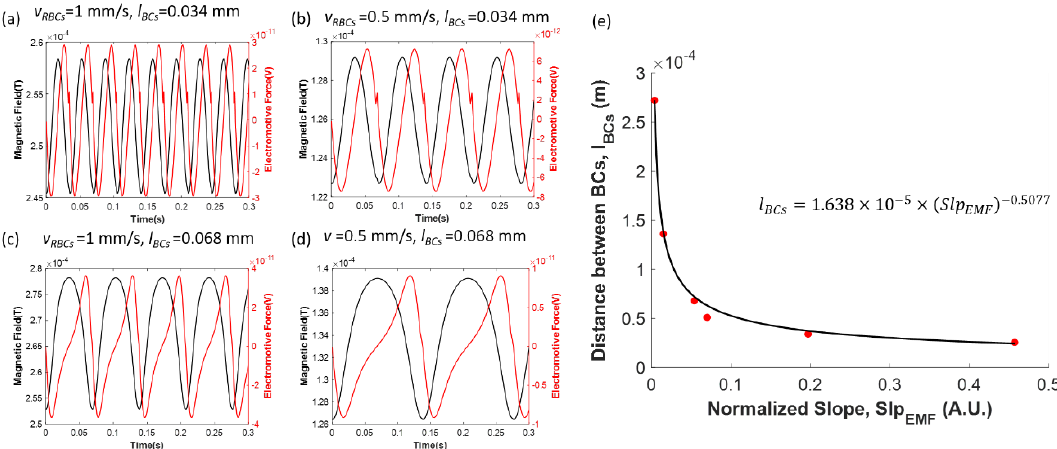
Figure 2. Measurement of the blood velocity using the induced electromotive force (EMF) generated at the microcoil. ( a – d ) The magnetic field generated by the flowing blood (black line), and the induced EMF measured at the microcoil (red line) when the blood velocity ( v ) and inter-RBC distance ( l BCs ) become 1 mm / s and 0.034 mm for ( a ), 0.5 mm / s and 0.034 mm for ( b ), 1 mm / s and 0.068 mm for ( c ), and 0.5 mm / s and 0.068 mm for ( d ). ( e ) The distance between adjacent RBCs ( l RBCs ) is plotted as a function of the normalized slope of induced EMF ( Slp EMF = 𝐸𝑀𝐹(𝑡 1 +Δ𝑡)−𝐸𝑀𝐹(𝑡 1 ) EMF maximum peak − EMF minimum peak ) where 𝑡 1 is the time when the RBC passes just below the microcoil and Δ𝑡 is 1 ms.